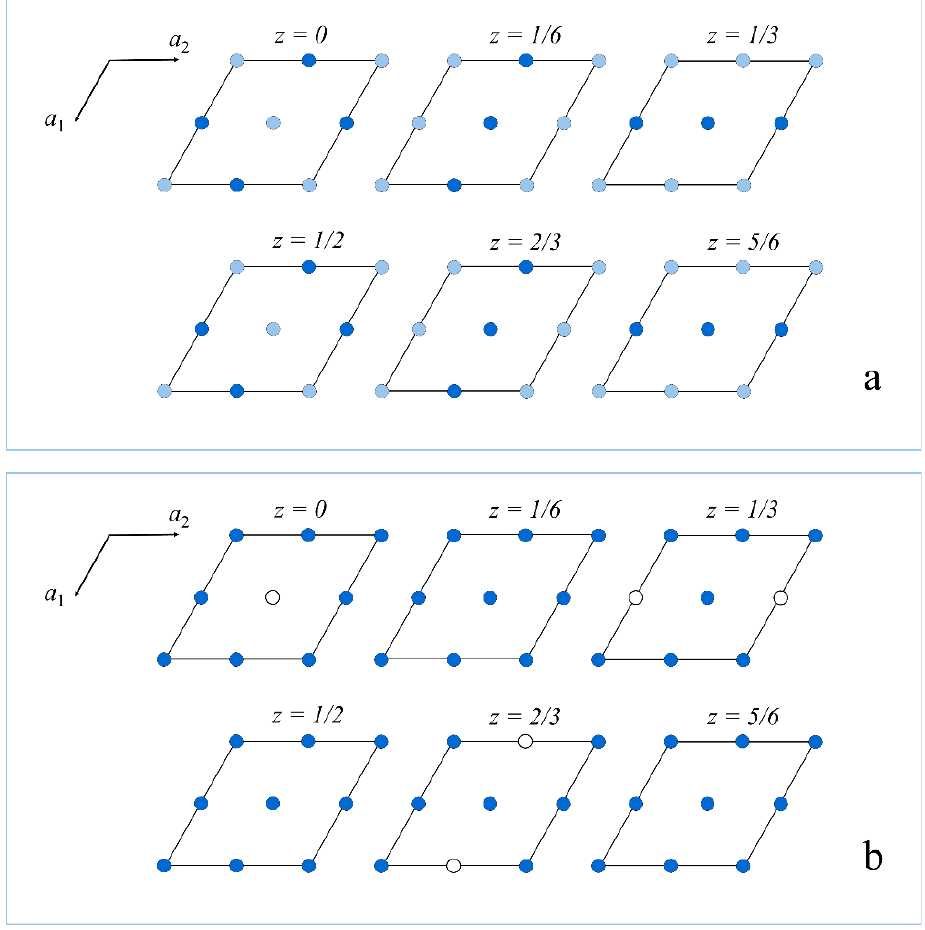
Figure 4. Metal distribution in eliopoulosite ( a ) and in synthetic 3 C -Fe 7 S 8 pyrrhotite ( b ). Blue and pale blue circles refer to metal positions with full and partial (75%) occupancy, respectively. White circles represent completely empty sites in synthetic 3 C -Fe 7 S 8 pyrrhotite [32]. The unit cell and the orientation of the structure are indicated.